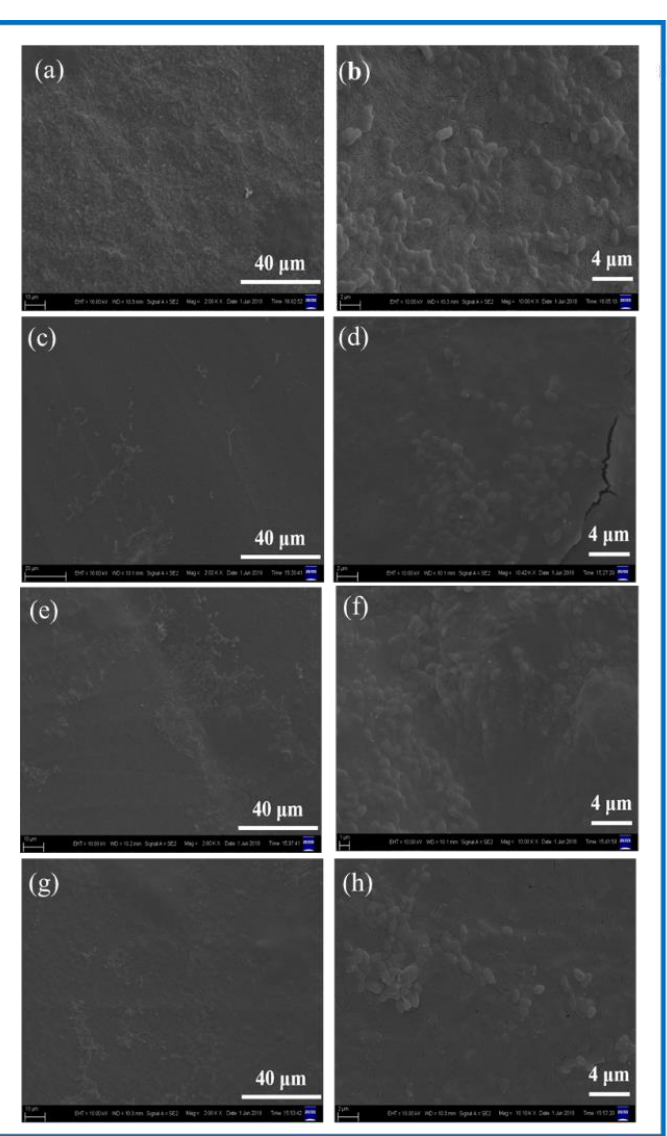
Figure 11. SEM of cell adhesion at different magnification. ( a , b ) BC membrane and 3D-printed PLA/BC composite scaffolds: ( c , d ) PLA/BC-1; ( e , f ) PLA/BC-2; ( g , h ) PLA/BC-3.